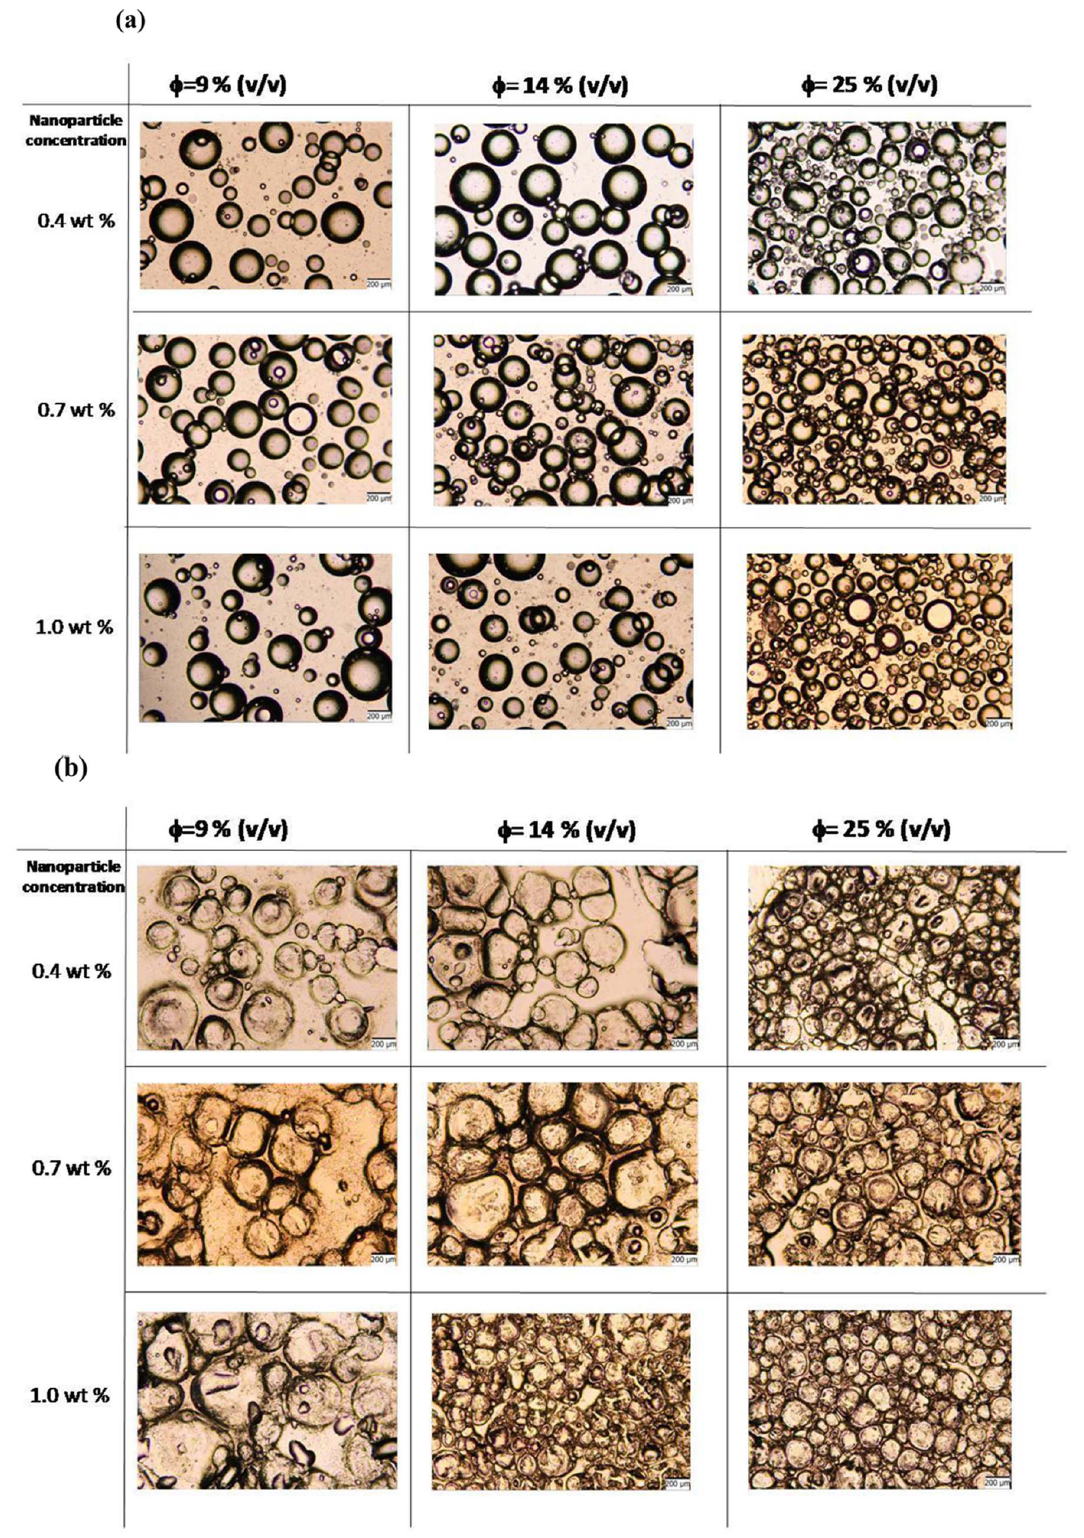
Figure 5. Optical microscope images of emulsions for altered concentrations of nanoparticles and internal phase volume fractions. Internal phase contains agarose gel. (a)Wet and, (b) dry emulsions. Scale bar represents 200 m m.